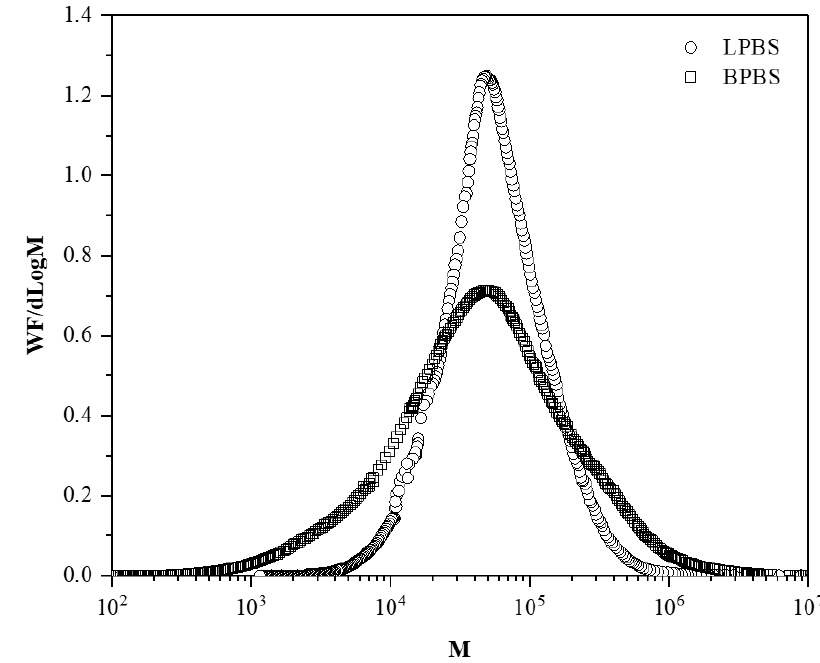
Figure 1. Molecular weight distributions of BPBS ( □ ) and LPBS ( ○ ).